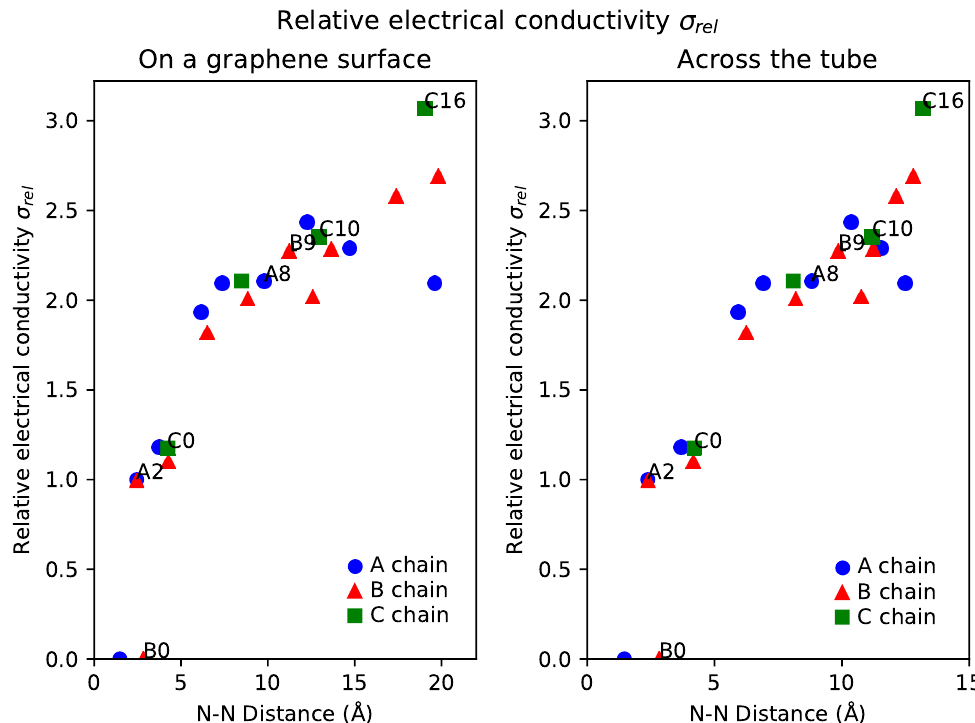
Figure 3. Relative electrical conductivity σ rel (S/m) of N-CNTs with respect to N–N distance between the two dopants. The plot on left is for N–N distances on an idealized graphene surface ( d surface ) and the plot on the right for N–N distances across the tube ( d tubular ), measured directly for the studied systems. See Figure 1 for the naming scheme. A-type positions are in blue circles, B-type positions are in red triangles, and C-type positions are in green